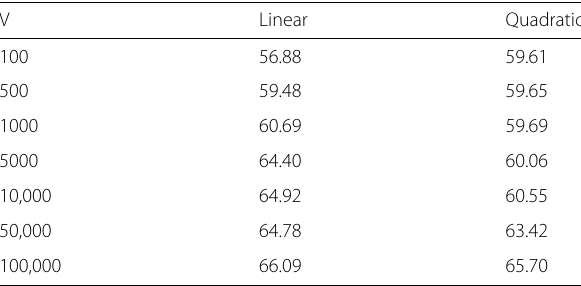
Table 3 Comparison of average server temperature under linear and quadratic control vs. V